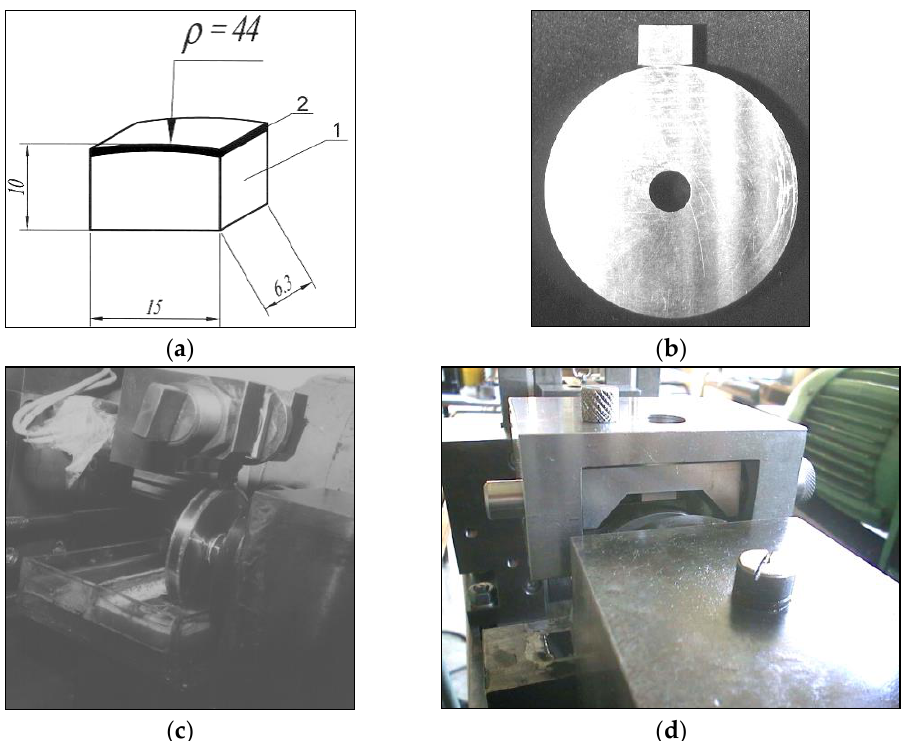
Figure 1. Tribological tests illustration: ( a ) Tribometer samples tested on tribometer (1—the base metal, 2—hard-faced layer, ρ —tooth curvature radius); ( b ) Appearance of the disc and block prepared for the test; ( c ) Tribometer TPD-3 with a disc submerged into oil and block above; ( d ) Block fixed in the holder before establishing the contact with the rotating disc.